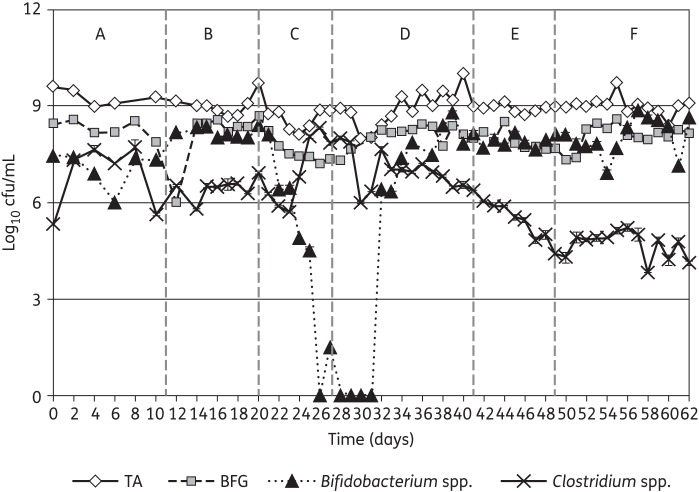
Mean viable counts (±SE) of obligate anaerobe bacterial groups (log10 cfu/mL) in vessel 3 of the SMT19969 250 mg/L/day gut model (period E). TA, total anaerobes (obligate and facultative).